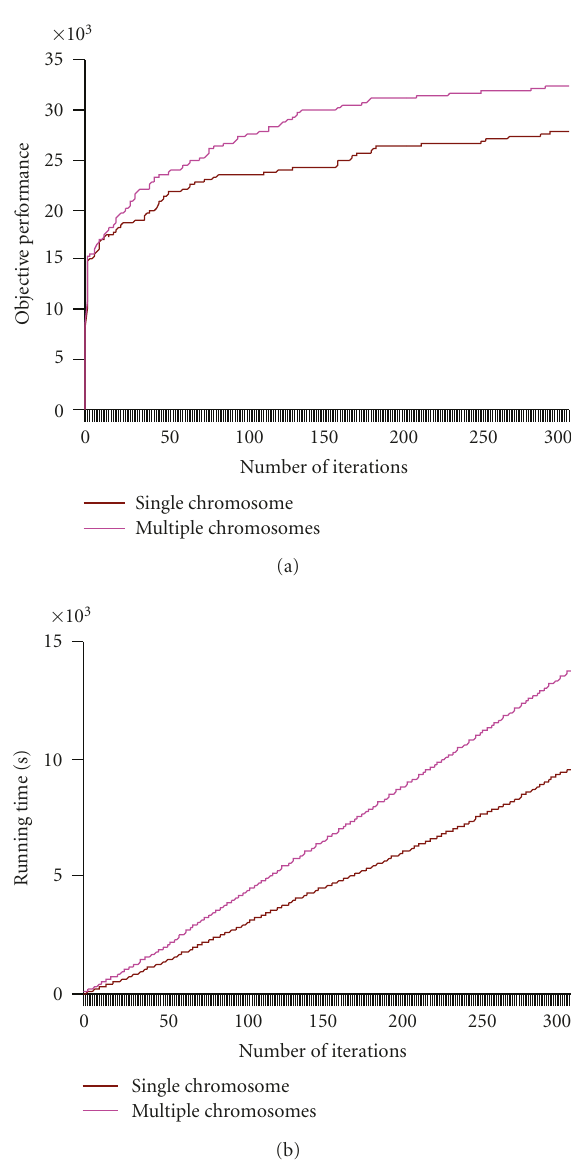
Figure 8: GA performance progress with number of iterations: (a) objective performance and (b) elapsed